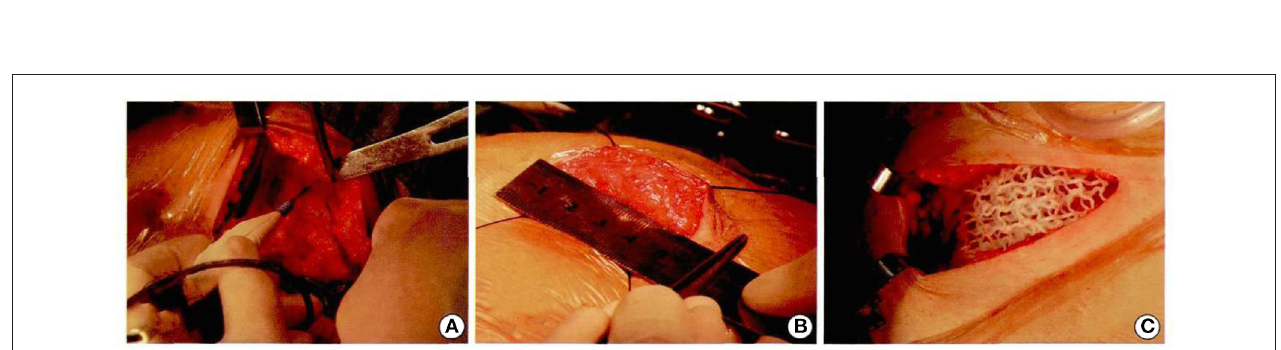
FIGURE 7 | Design and printing of personalized biodegradable implants for patients. (A,B) Breast magnetic resonance imaging front view; (C,D) Three dimensional images were constructed according to the MRI image; (E) Simulated three dimensional images of tumor resection and scaffold implantation in surgery. (F) General shape of degradable breast implants (the material is polycaprolactone) and internal structure of degradable breast implants ( 26).